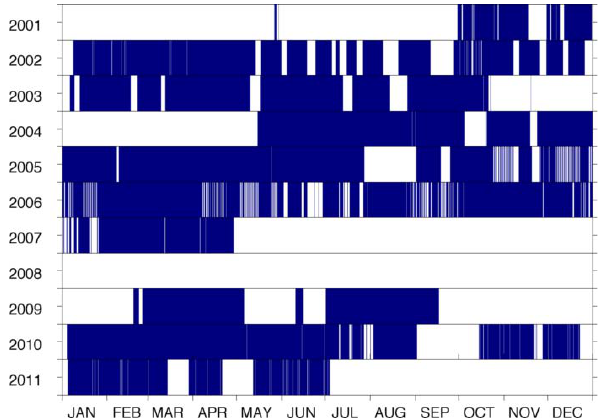
Fig. 2. Schematic diagram showing when the Ascension Island radar has been operational (blue) and non-operational (white) since deployment in